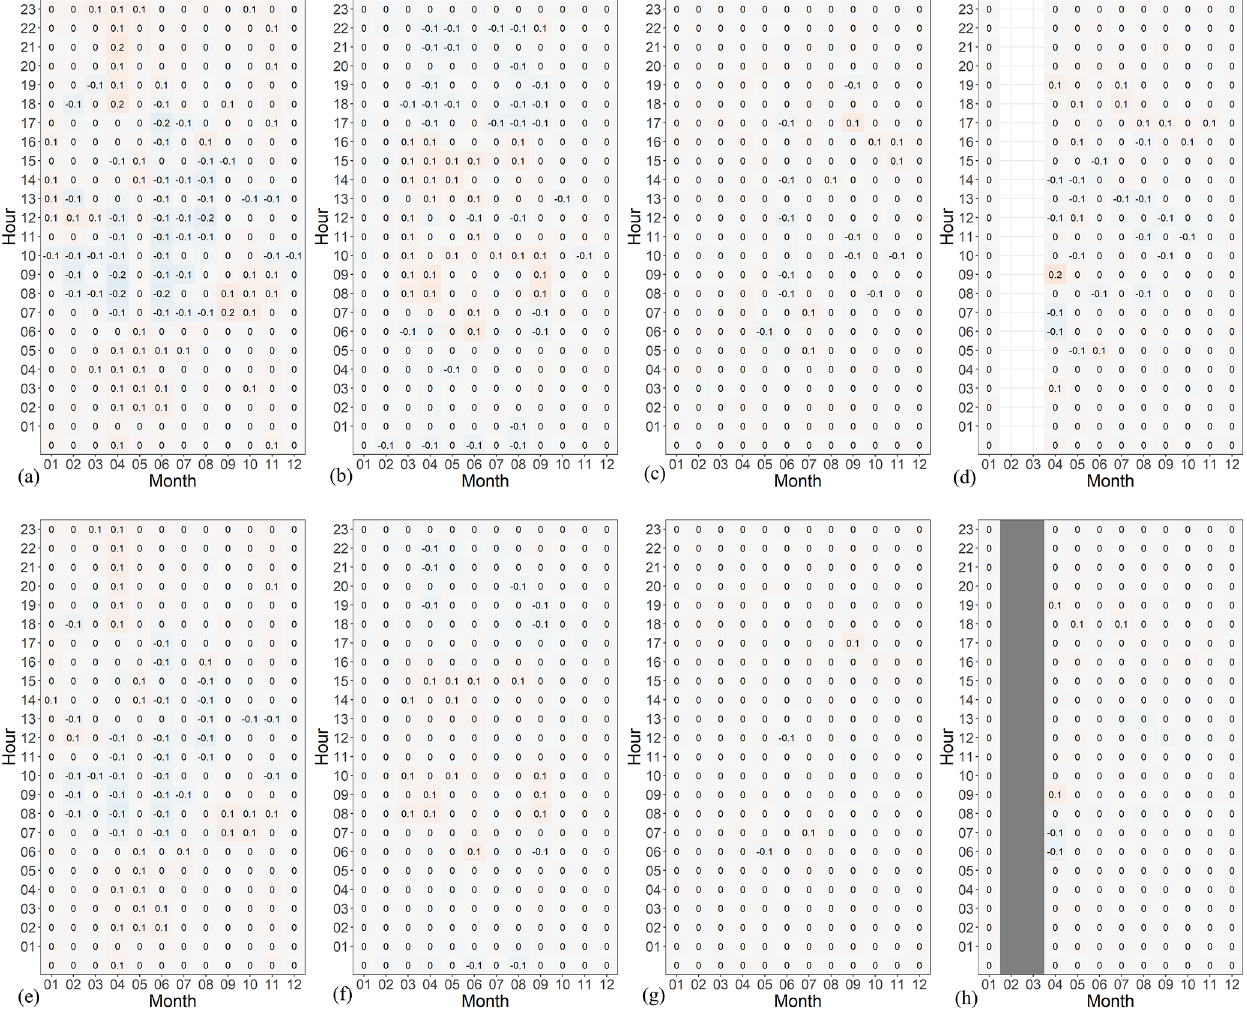
https://doi.org/10.5194/essd-14-4681-2022 Earth Syst. Sci. Data, 14, 4681–4717,